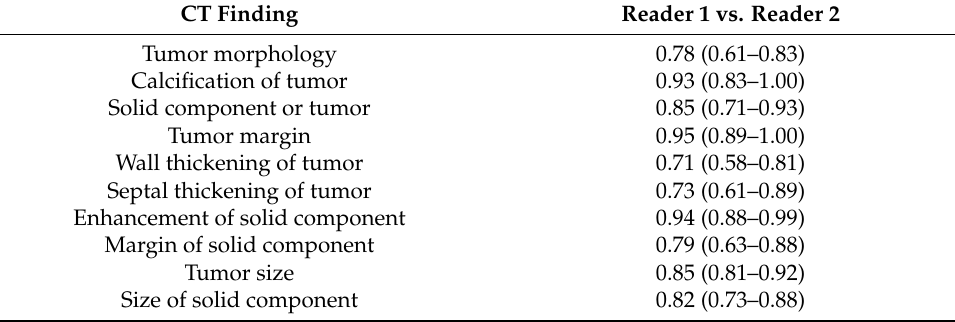
Table 4. Inter-observer agreement among readers of each CT finding for